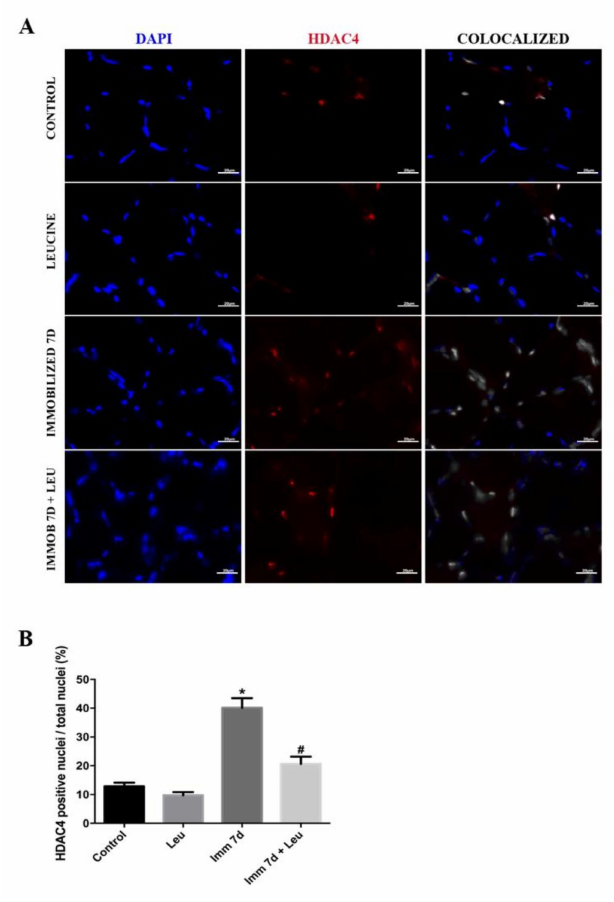
Figure 5. HDAC4 colocalization analysis after 7 days of immobilization and leucine supplementation. ( A ) Representative immunofluorescence photomicrographs of HDAC4 in soleus muscle after 7 days of immobilization, HDAC4 (red), DAPI (blue, used for nuclei identification), and colocalized (white) scale bar 20 µ m. Less intense puncta reflect nuclei identified at either di ff erent focal planes or nuclei that were cut close at the edge. ( B ) Number of HDAC4 positive nuclei per total nuclei (%) ( n = 5 per group, two independent experiments were performed). Data are expressed as mean ± SEM. Statistical analysis included one-way ANOVA followed by Tukey’s posthoc test. * p < 0.05 vs. control group; # p < 0.05 vs. immobilized 7 d